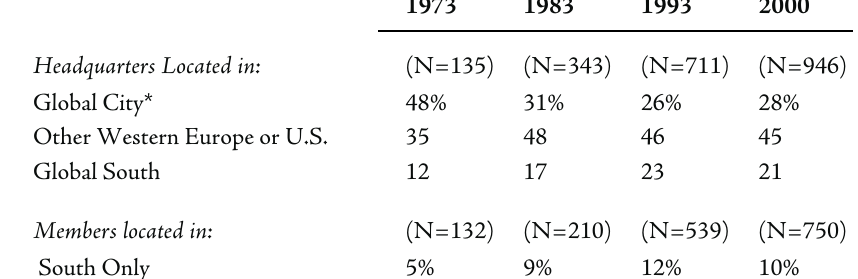
Table 3: Access, Legitimacy and Survival: Comparisons of Core- and Periphery- based TSMOs Scope of Member Base N